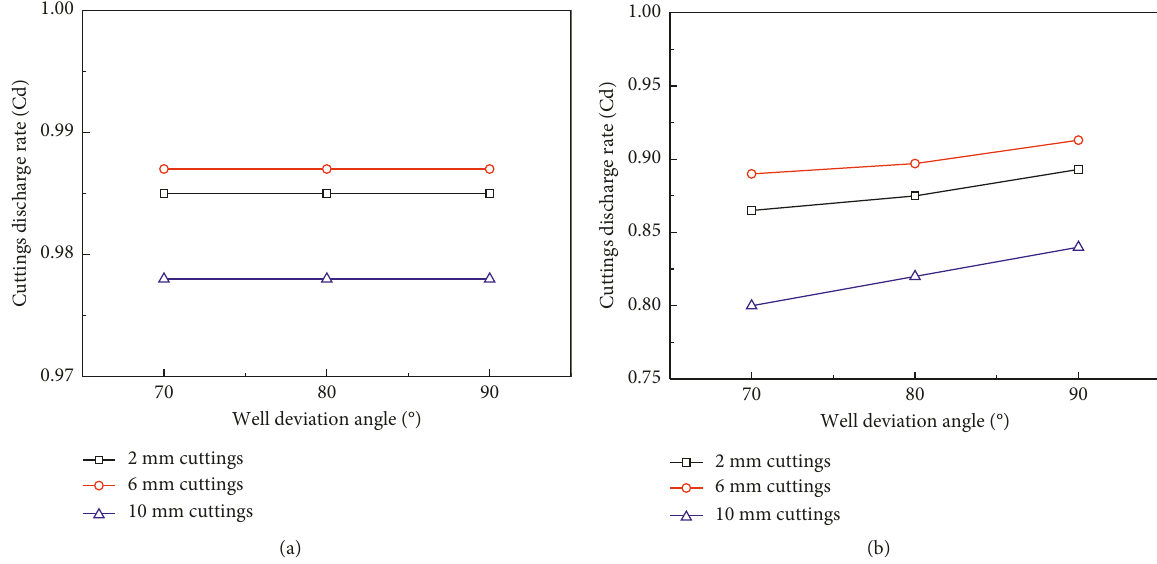
Figure 11: Influences of the well deviation angle and cuttings diameter on the cuttings discharge rate: (a) under high rotational speed (40r/ min) and high flow rate (5L/s) conditions, and (b) under low rotational speed (0r/min) and low flow rate (1 L/s) conditions. Table 5: Summary of experimental